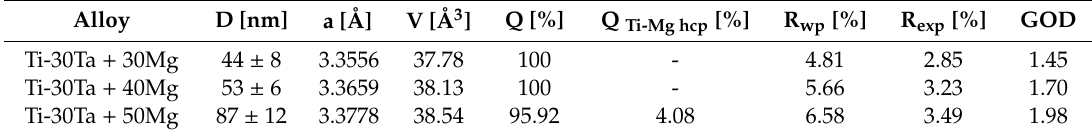
Figure 3. Example of TEM micrograph and the grain size distribution of the Ti-30Ta-30Mg alloy. Table 1. Crystallographic data of the powders after mechanical Table 1. Crystallographic data of the powders after mechanical alloying.